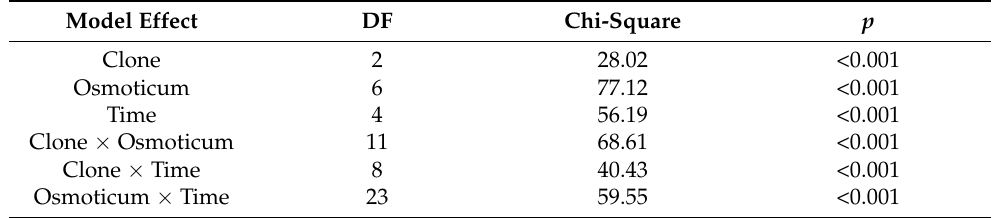
Table 3. ANOVA table for mortality with Wald statistics for GEE analysis (DF—degrees of freedom; chi-square—test statistics; p — p